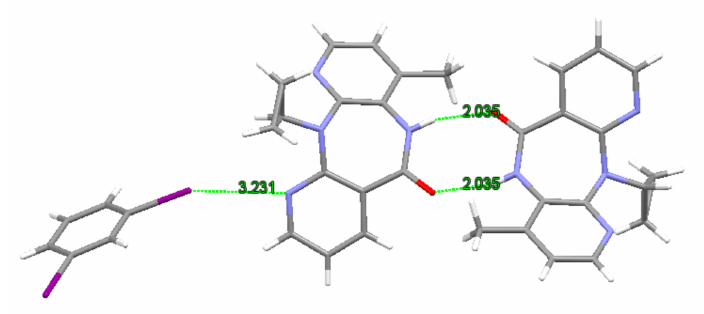
Figure 2. Supramolecular contacts (viz., hydrogen and halogen bonds) in NVP · 1,3-DIB co-crystal.